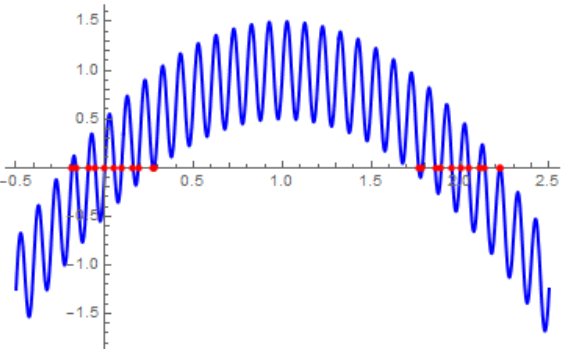
Figure 2. The behavior of the function g and the position of its roots (the red dots show the location of the zeros of the nonlinear functions).